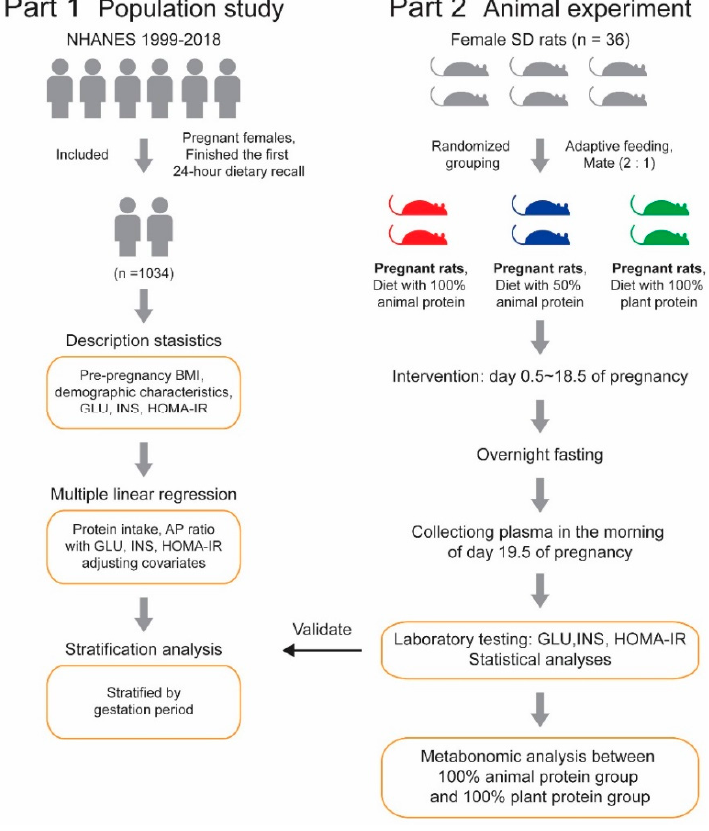
Figure 1. Design of this study.